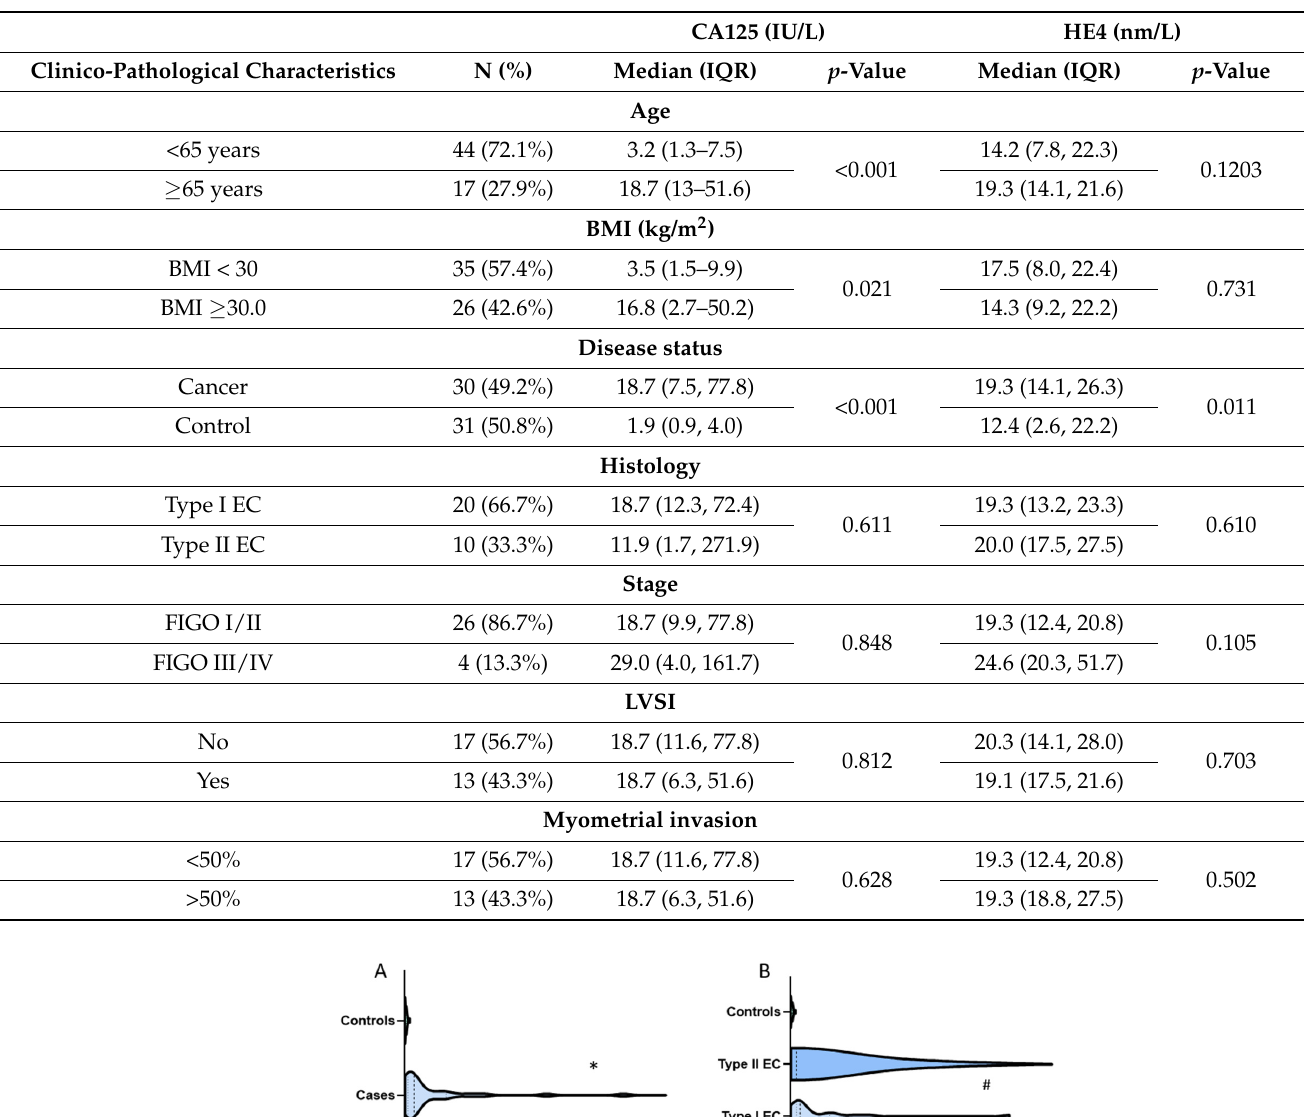
Table 1. Urine CA125 and HE4 levels in women with endometrial cancer and symptomatic controls (discovery cohort).